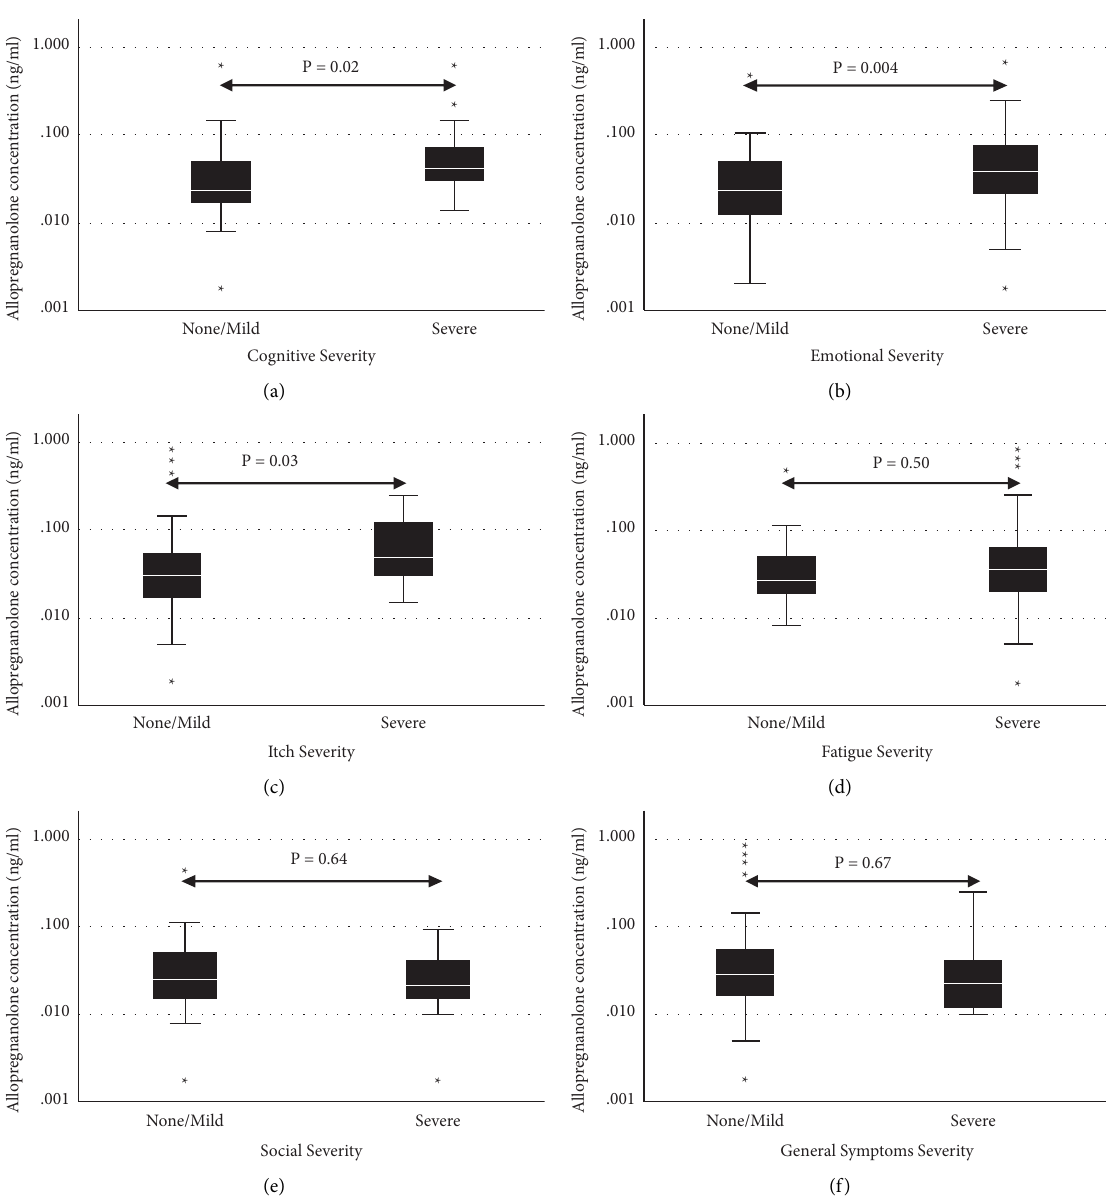
Figure 3: Symptom severity (none/mild vs. severe) as defned by the PBC-40 questionnaire domains, according to allopregnanolone levels (ng/ml). (a) Cognitive; (b) emotional; (c) itch; (d) fatigue; (e) social; (f) general